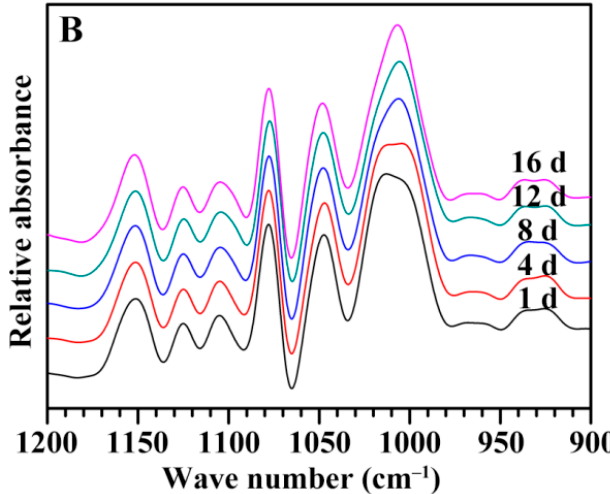
Figure 12. The ATR-FTIR pattern of endosperm starch during seedling growth. ( A ) GLXN, ( B ) GTR.